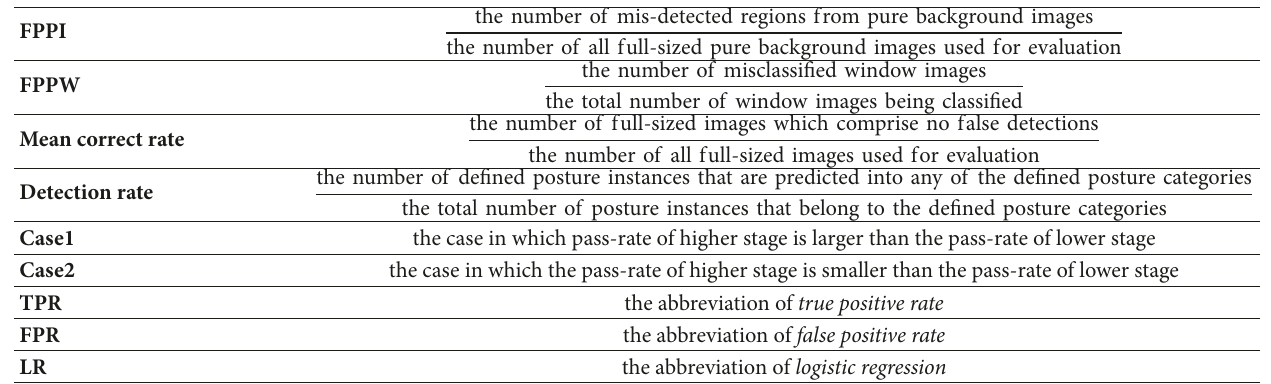
Table 4: List of acronyms, definitions, and terminology